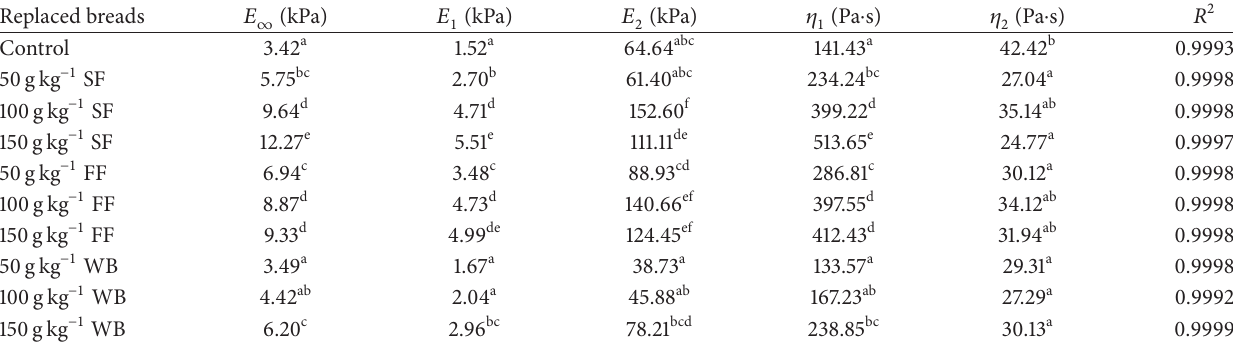
Table 6: Relaxation parameters of loaves replaced with FF, SF, and WB (50, 100, and 150g kg −1 ) and control a . Replaced breads 𝐸 ∞ (kPa)